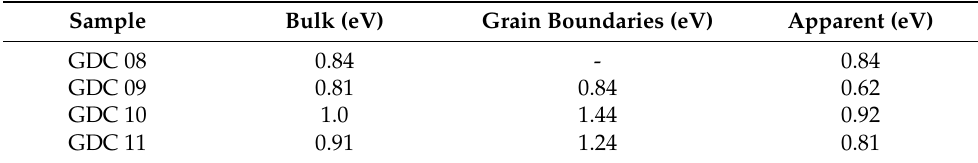
Figure 8. Arrhenius plots of the total resistance as a function of temperature for all GDC films. Table 4. Activation energy for each contribution.